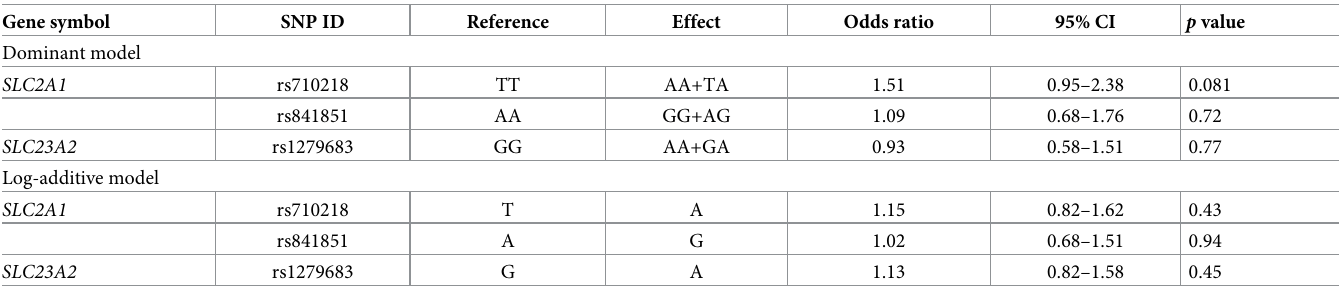
Odds ratio of the functional variant was calculated by multivariate logistic regression analysis, adjusted for the effects of APOE4 phenotype, baseline age, follow-up period, baseline MMSE points, and sex. The upper half shows the results of the dominant model and the lower half shows the results of the log-additive